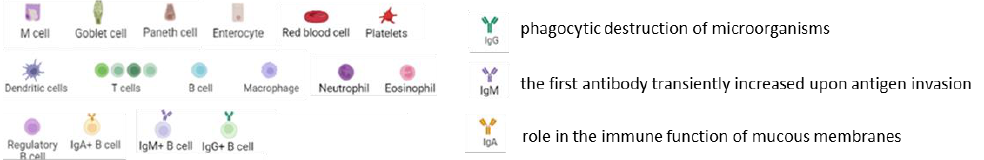
Figure 2. Effects of probiotics on the immune B response in host. Probiotics boost the immune B response in a local manner. Probiotics increase total IgA + and IgM + B cell numbers in small intestine and increase IgA secretion in the lamina propria. Probiotics induce a higher percentage of total and TGF β + B cell in Peyer’s Patches and increase IgA, IgG and IgM secretion and IL-10 + B cell frequency in the serum. To conclude, probiotics induce a higher expression of D40, CD80 and CMH-II on B cell surface and increase genes included in B cell activation in the circulating B cells.